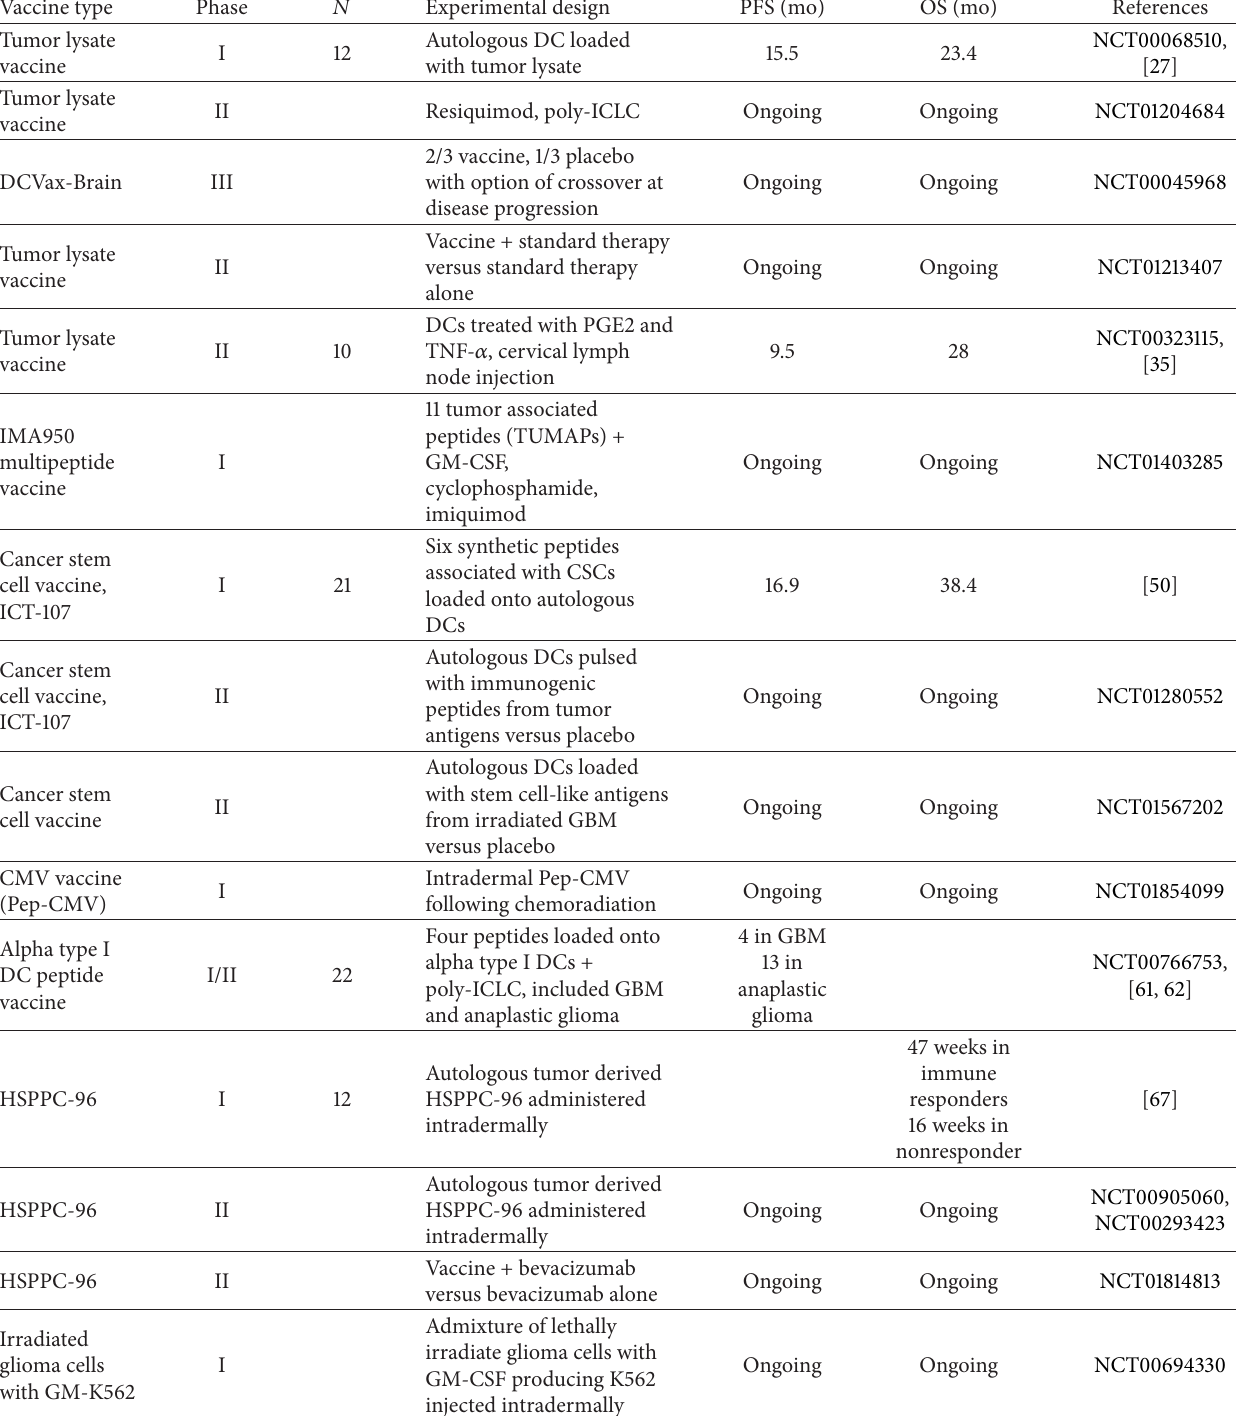
Table 3: GBM vaccine